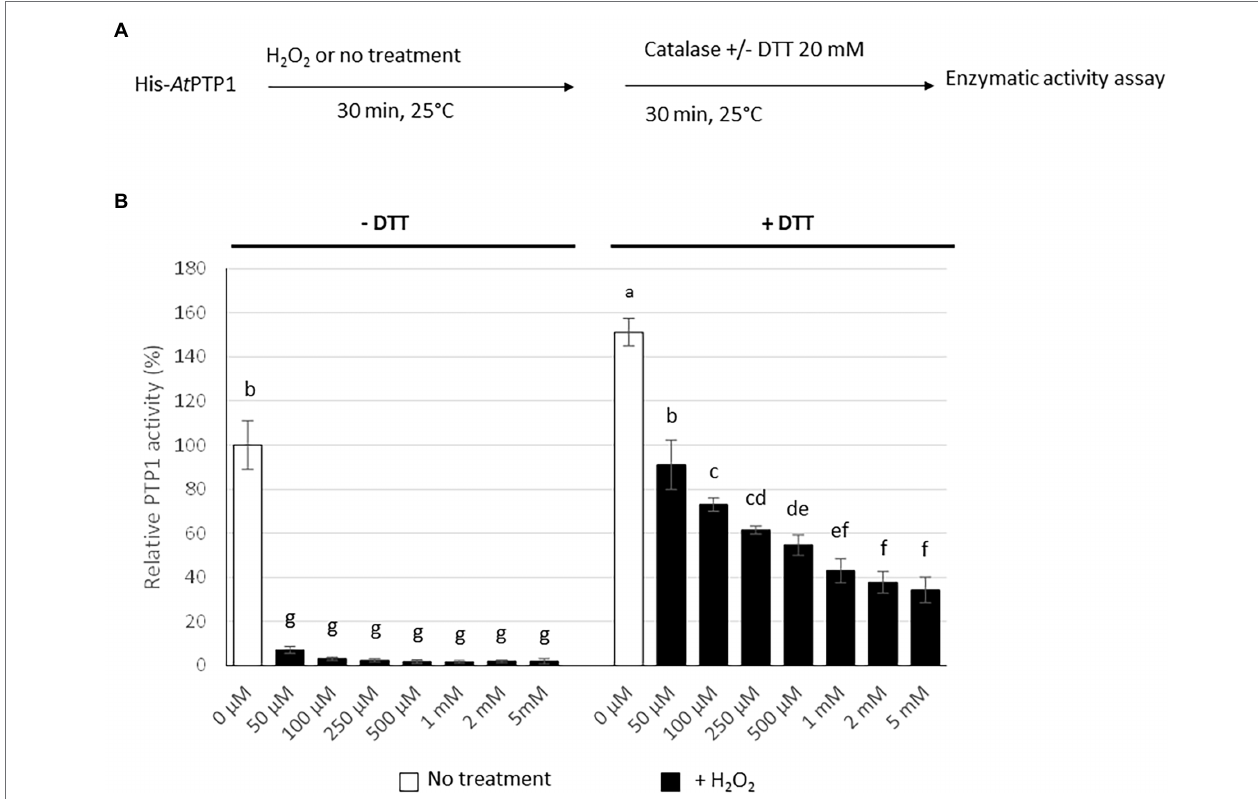
FIGURE 4 | Effect of H 2 O 2 treatment on His- At PTP1 activity in the absence or presence of DTT. (A) Experimental design. (B) The enzymatic activity of His- At PTP1 was measured following treatment with 50, 100, 250, and 500 μ M or 1, 2, or 5 mM of H 2 O 2 in the absence or presence of 20 mM DTT. Results are expressed relative to the enzyme activity measured without H 2 O 2 or DTT treatments. Values are means of four measurements ±SEM. The results shown are from one representative experiment among three independent experiments. Significant differences are denoted by different letters ( p ≤